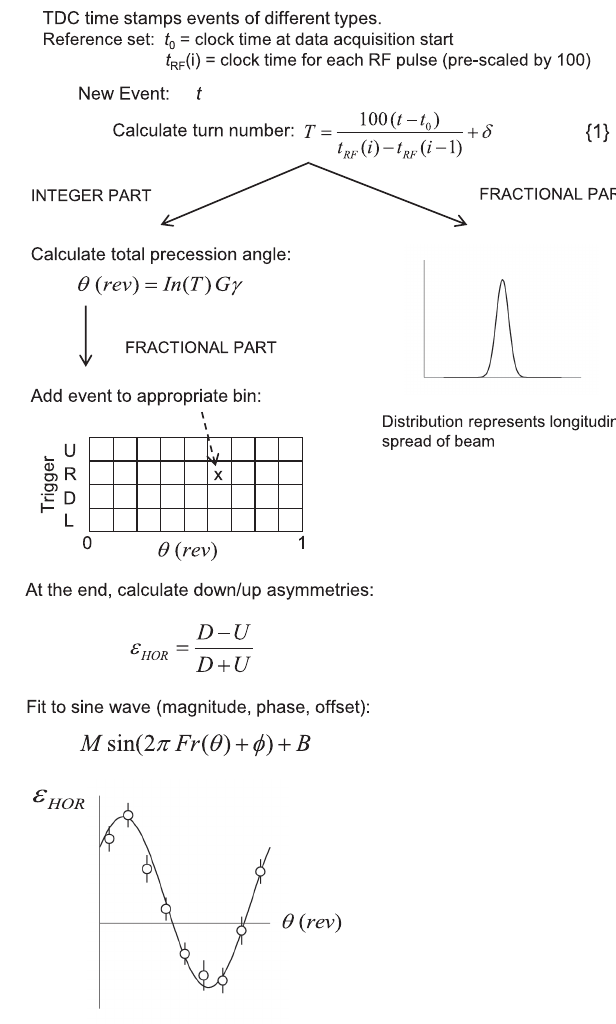
FIG. 3. Flow chart of the analysis scheme. See text for details. “ In ” refers to the integer part of the angle θ and “ Fr ” refers to the fractional part. The value of δ in Eq. {1} is chosen to maintain a single value for the integer part of the turn number for all parts of the beam bunch (harmonic h ¼ 1 ). See the text for a complete